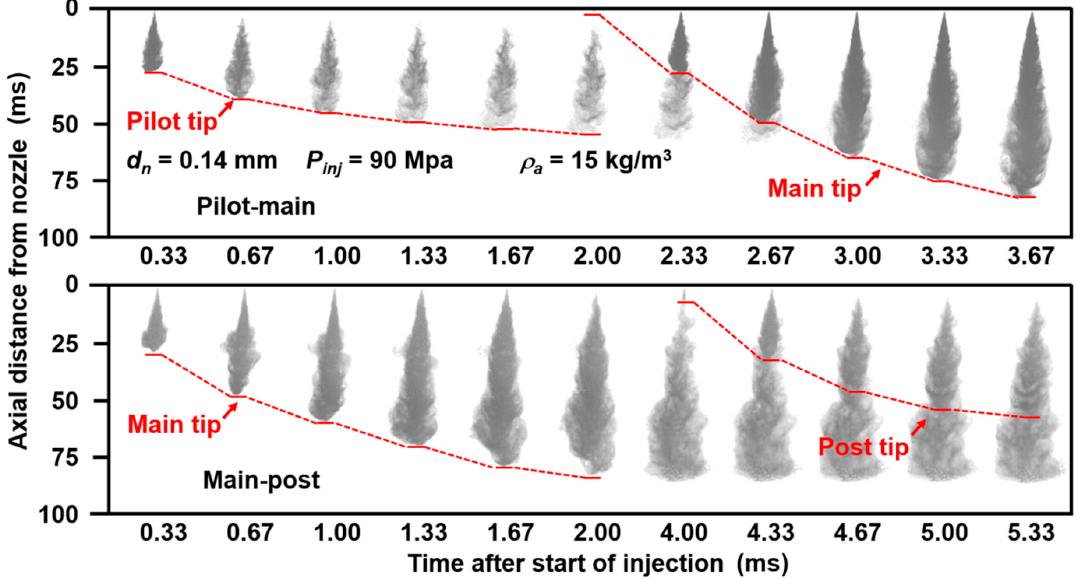
Figure 8. The instantaneous spray development for the pilot-main and main-post injection